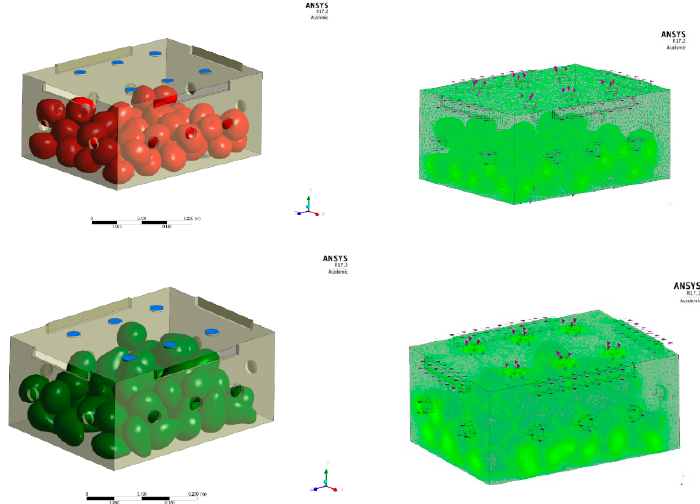
Figure 6. Representative elemental volumes (REVs) of tomatoes (top) and avocadoes (bottom) generated using YADE. The generic box contains 50 pieces of produce and can serve as a single unit in a much larger stack of produce. The images on the right for each case show the discretized version of the REV.